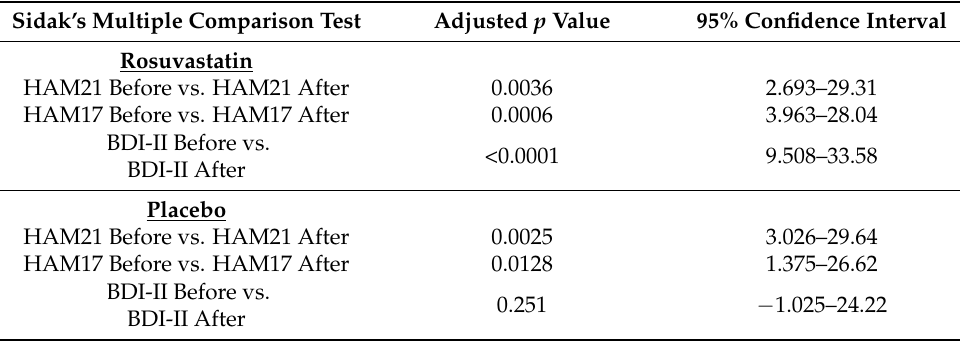
Table 3. Statistical differences in mood before and after the study.